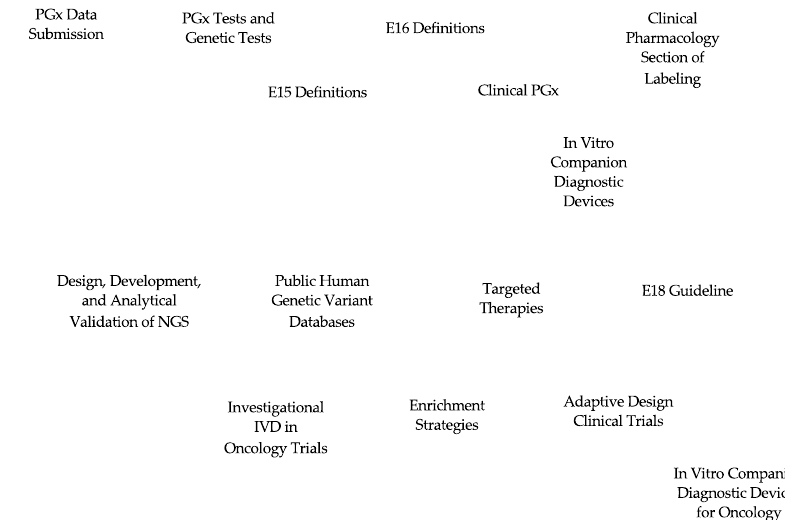
Figure 2. Trends in annual proportion of new drug approvals with PGx labeling and finalized regulatory guidance related to pharmacogenomics from 2000 to 2020, with data through 31 July 2020. E15, E16, and E18 Guidance were developed within the International Conference on Harmonisation of Technical Requirements for Registration of Pharmaceuticals for Human Use (ICH) and endorsed by the ICH Steering Committee at Step 4 of the ICH process